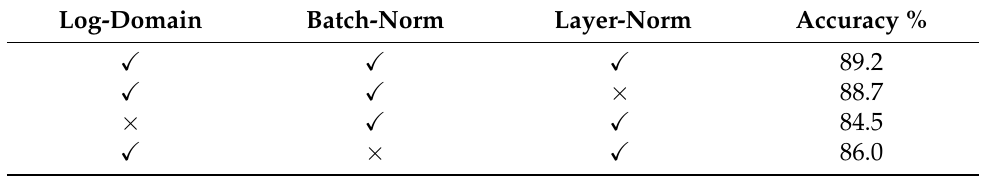
Table 5. Effect of different normalization settings on the M 1 model’s performance (validation